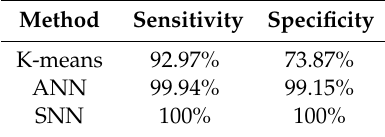
Table 9. Sensitivity and specificity comparison of three